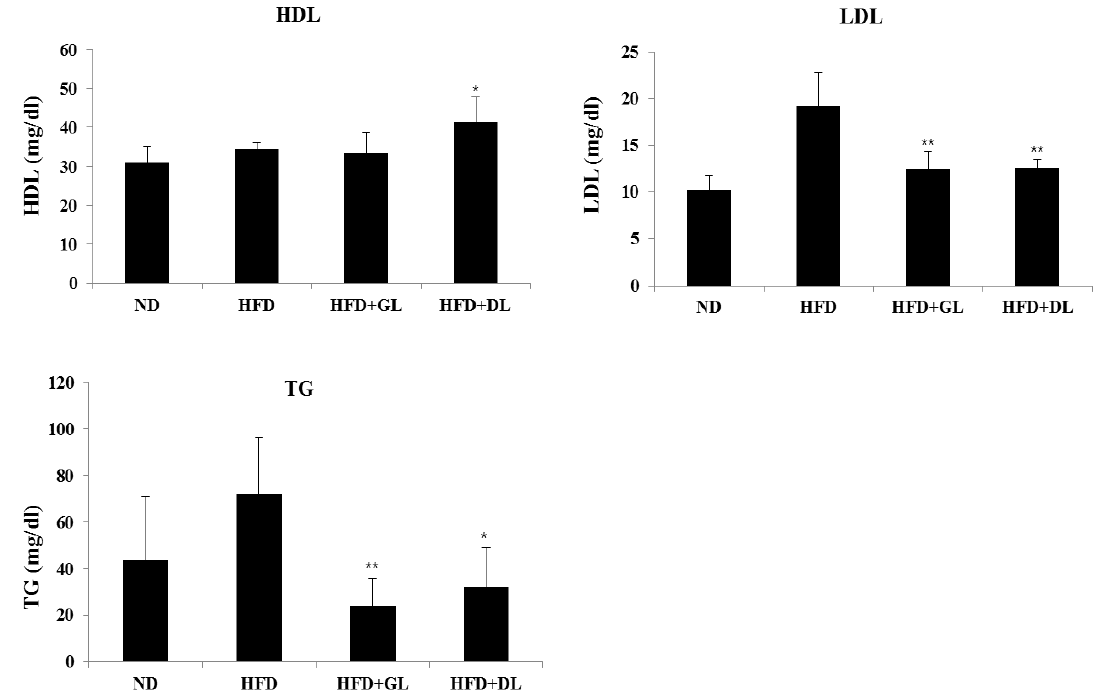
Figure 2. Plasma biochemical values in male rats. Blood plasma were collected and analyzed for TG (triglycerides), HDL (high-density lipoprotein cholesterol), and LDL (low-density lipoprotein cholesterol). Significant differences from the positive control group (HFD), ** p < 0.01 or * p < 0.05, are indicated. Bar graphs show the mean ± SD from seven individual rats per group.